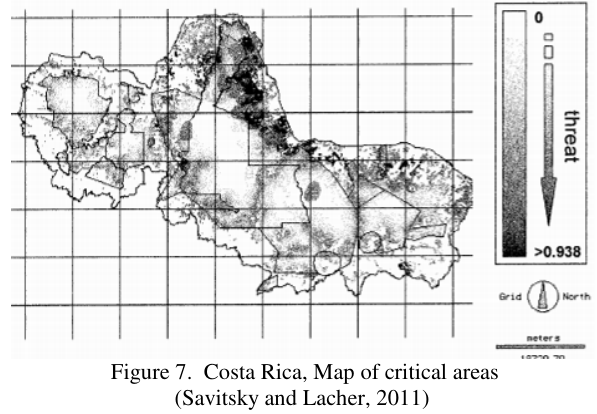
Figure 7. Costa Rica, Map of critical areas (Savitsky and Lacher,